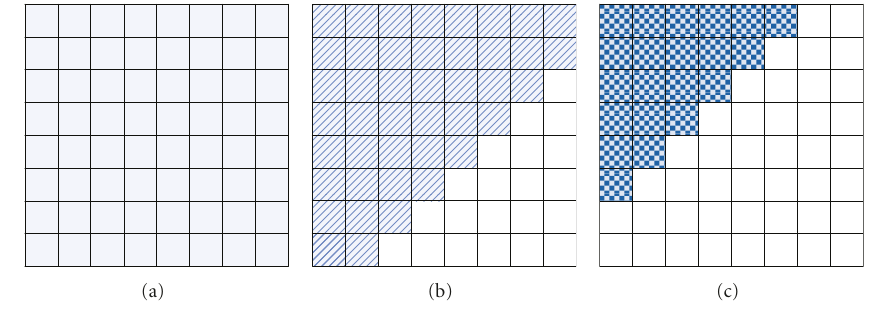
Figure 4: Data pruning patterns in IDCT.